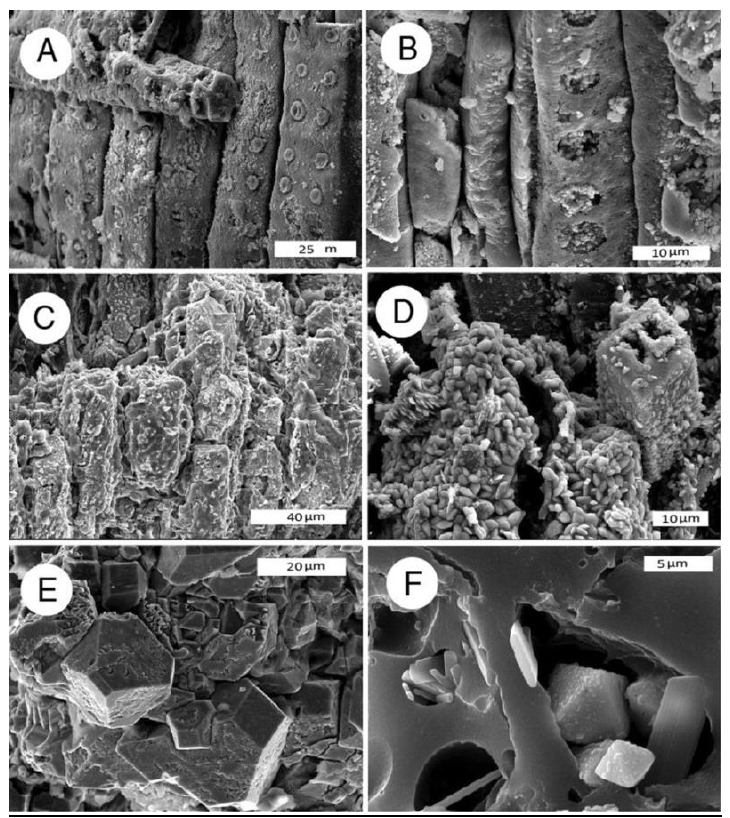
Figure 10. SEM images of iron-mineralized wood. ( A , B ) Iron oxide, Piocene, Burney, California USA, oblique radial view; ( C , D ) Iron oxide, Lower Cretaceous, Antler, Oklahoma USA; ( C ) radial view; ( D ) oblique transverse view shows hematite microcrystals replacing cell walls; ( E , F ) octahedral pyrite crystals in carbonized wood, oblique transverse view. Eocene, Yuba River, Nevada County, California USA.